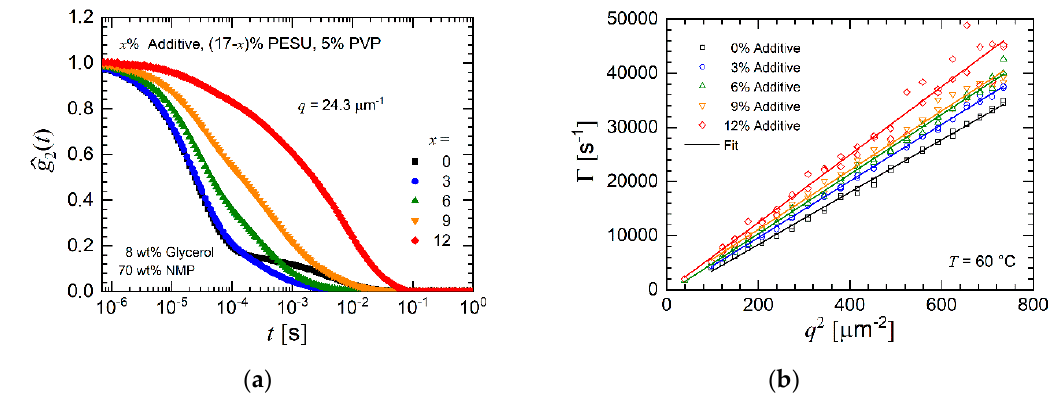
Figure 8. ( a ) Normalized intensity autocorrelation as a function of time for the additive solutions AS 0 to AS 12 at a constant value of the scattering vector. The measurement temperature was 60 °C. ( b ) Relaxation rate for each additive concentration as a function of the square of the magnitude q of the scattering vector for the fast relaxation process.